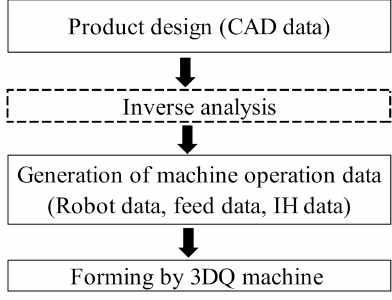
Figure 2. 3DQ production